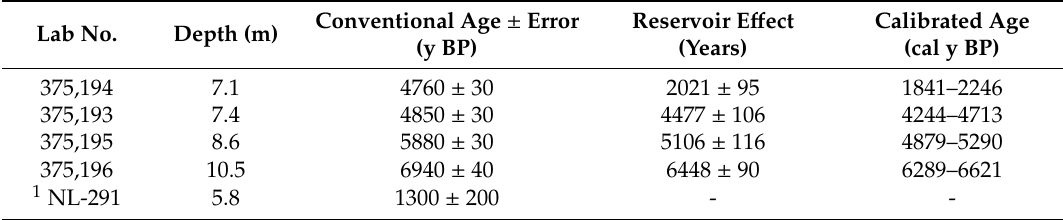
Table 1. Radiocarbon dating on the organic materials from core ECS-DZ1. Lab No.